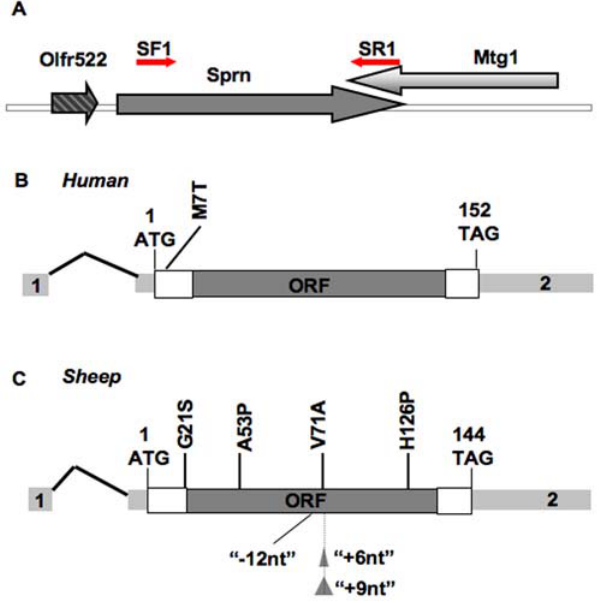
Figure 1. Overview of SPRN genes. (A) Consensus chromosomal structure of mammalian SPRN deduced from mouse and human prototypes: SPRN is flanked by the Olfr322 and Mtg1 genes. Oligonucleotide primers SF1 and SR1 used to amplify sheep SPRN sequences were deduced from this consensus structure. Panels B and C (not to same scale as Panel A) represent mRNAs encoding Human (B) and (C) sheep SPRN . Light grey boxes 1 and 2 represent the exons. The entire ORF (dark grey) of SPRN is located on exon 2. The common polymorphisms discussed in the main text are represented, as well as the indel variations (not to scale) in ovine SPRN